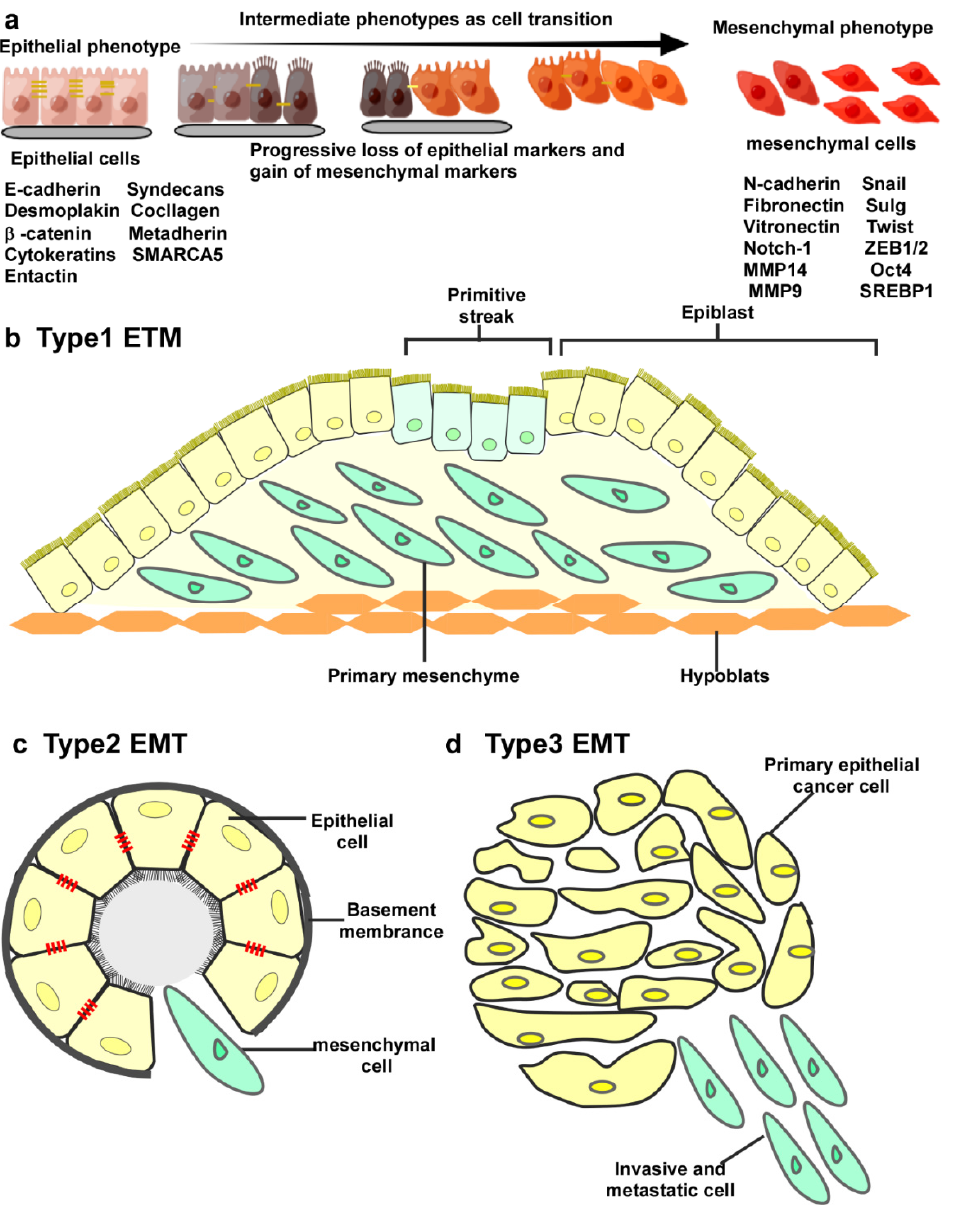
Figure 2. EMT transfer schematic diagram and three typical categories. ( a ) During the transition from an epithelial phenotype to mesenchymal phenotype, cells lose their intercellular connections and gradually separate from the basement membrane. Four mesenchymal genes, including interstitial N-cadherin and fibronectin, are upregulated, whereas E-cadherin, vitronectin, desmoplakin, and laninmin are downregulated. ( b ) Type I EMT is associated with embryo implantation and gastrulation. The ectoderm generates primary mesenchyme through EMT and then forms the secondary epithelium and gradually differentiates into other cells. ( c ) Type II EMT is associated with wound healing, is more persistent than type I, and occurs primarily in the context of inflammation. ( d ) Type III EMT is associated with tumor metastasis and facilitates tumor metastasis and